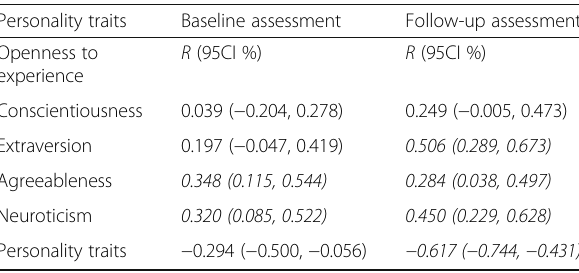
Table 4 Pearson correlation between personality traits and social desirability Personality traits Baseline